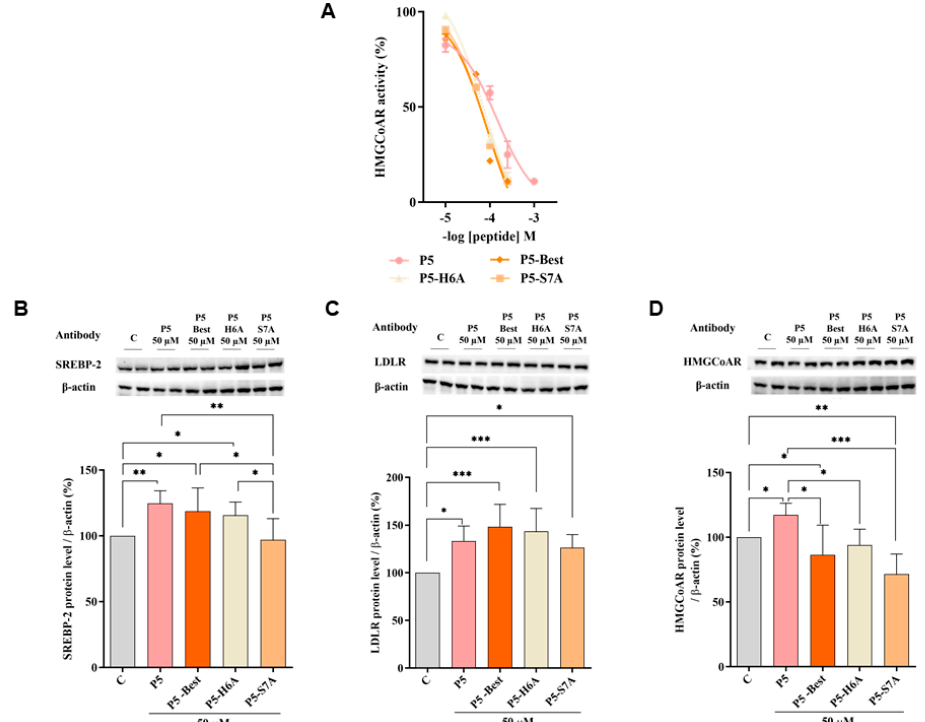
Figure 4. Modulation of the LDLR pathway in HepG2 cells treated with P5 and P5 analogs. ( A ) In vitro inhibition of HMG-CoAR activity. ( B ) The effect on SREBP-2 protein levels, ( C ) LDLR protein levels, and ( D ) HMG-CoAR protein levels after the treatment of HepG2 cells with P5 and P5 analogs, respectively. Data points represent the average ± SD of four independent experiments performed in duplicate. C vs. P5 and P5 analog samples were analyzed using a one-way ANOVA, followed by Tukey’s test; (*) p < 0.05, (**) p < 0.01, and (***) p < 0.001. C: control sample.